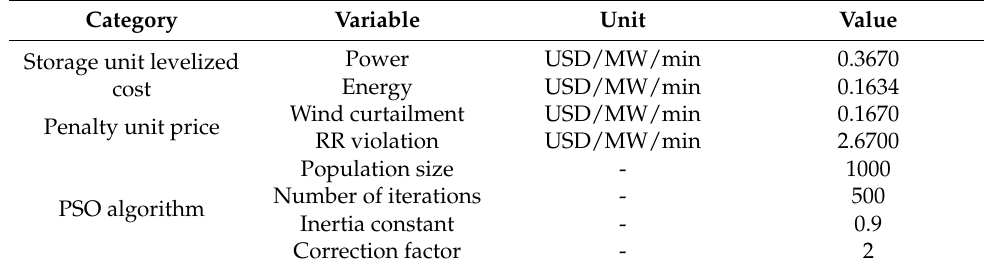
Table 2. Numerical data used in the case study.